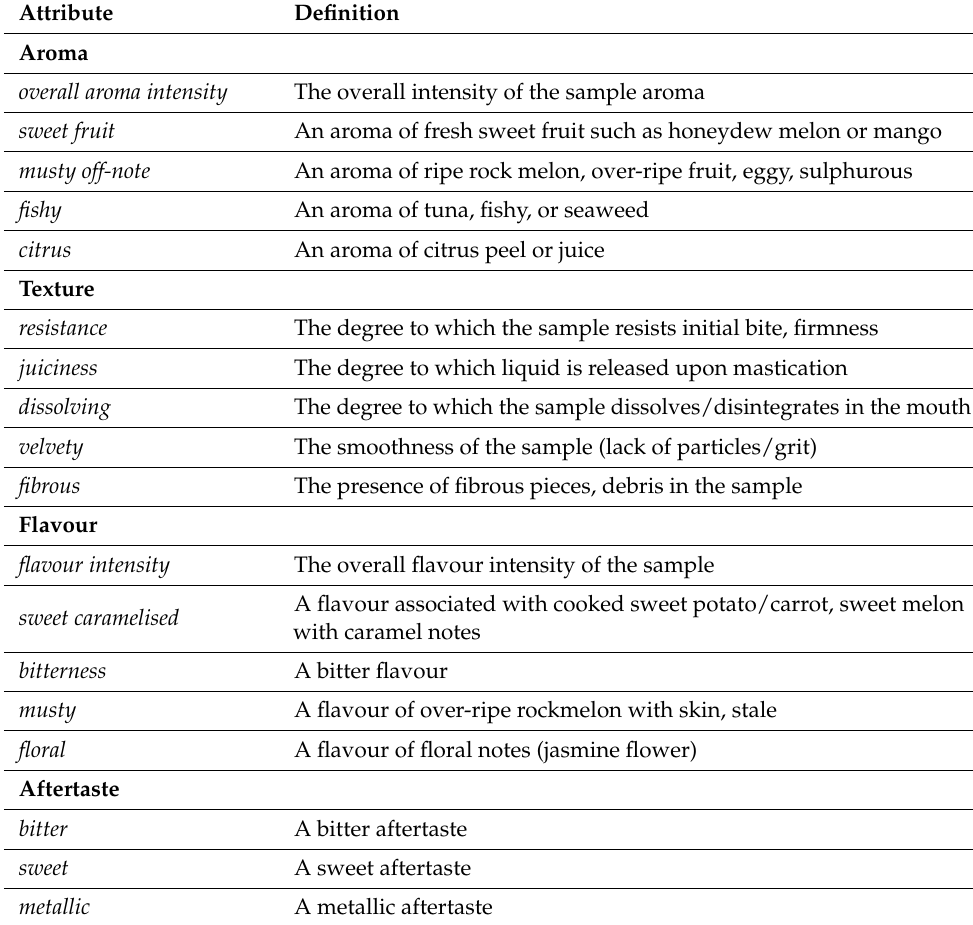
Table 5. Sensory panel testing